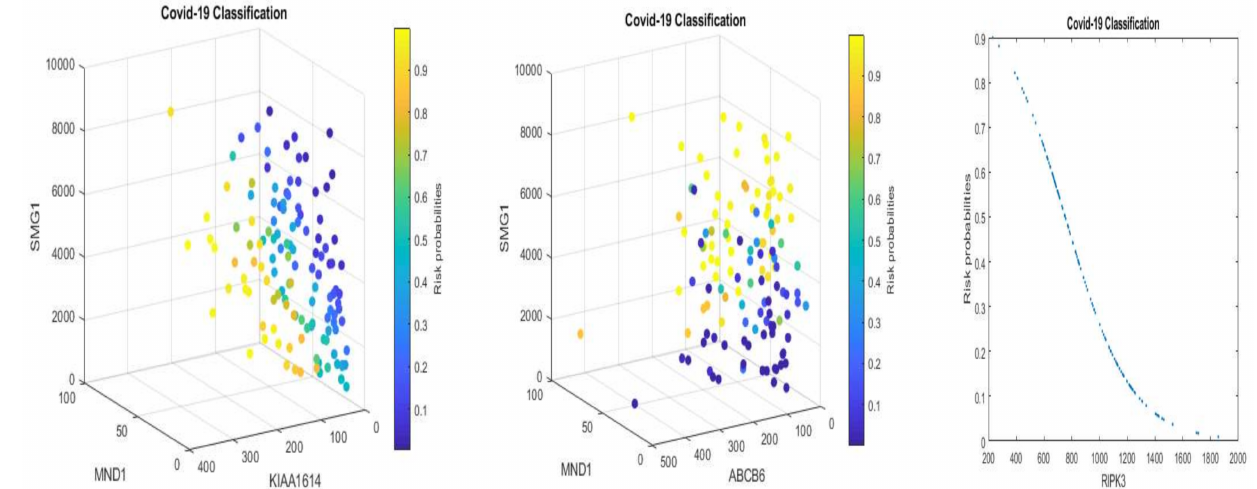
Figure 2. COVID-19 classifiers using EC data with the units corresponding to Table 3: visualization of gene-gene relationship and gene-risk probabilities. Note that 0.5 is the probability threshold. The left panel is for CF-I with the X-axis being MND1, Y-axis being KIAA1614, and Z-axis being SMG1. The risk probability bar is on the right. The middle panel is for CF-II with the X-axis being MND1, Y-axis being ABCB6, and Z-axis being SMG1. The risk probability bar is on the right. The right panel is for CF-III with the X-axis being RIPK3 and the Y-axis being the risk